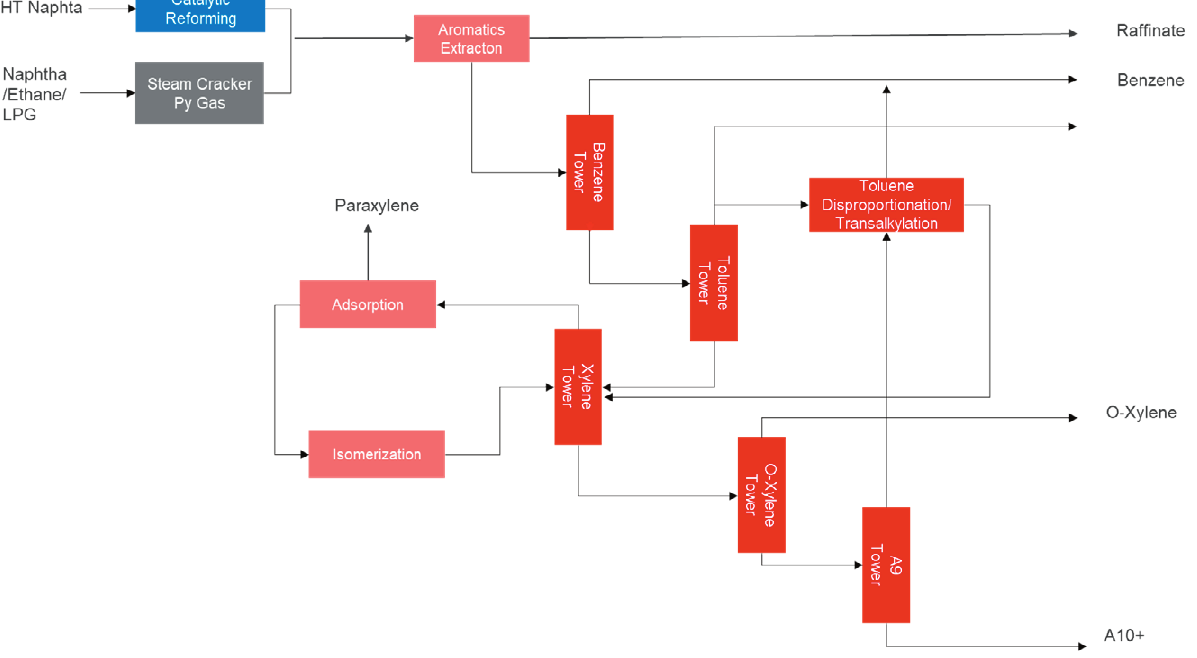
Figure 7. Aromatic Extraction